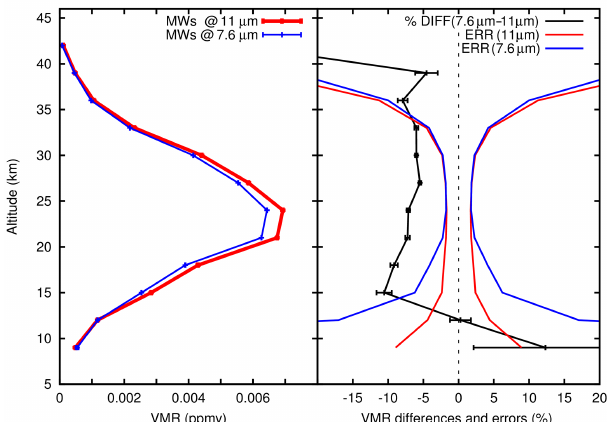
Figure 3. Average MIPAS-observed spectrum (black) in the 1314– 1320cm − 1 spectral region, and spectra simulated with the MIPAS- OLD (magenta line) and the MIPAS-2015 (orange line) HNO 3 linelists. For better readability of the plot, the average orange and magenta lines were shifted by 100 and 200nW ( cm 2 srcm − 1 ) − 1 re- spectively. The blue and the red lines are the residuals obtained with the MIPAS-OLD and the MIPAS-2015 linelists respectively.